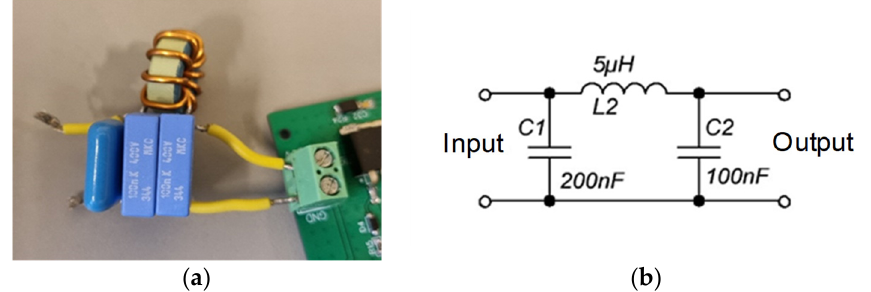
Figure 11. An image of the ∏ filter ( a ) and its schematic diagram ( b ).